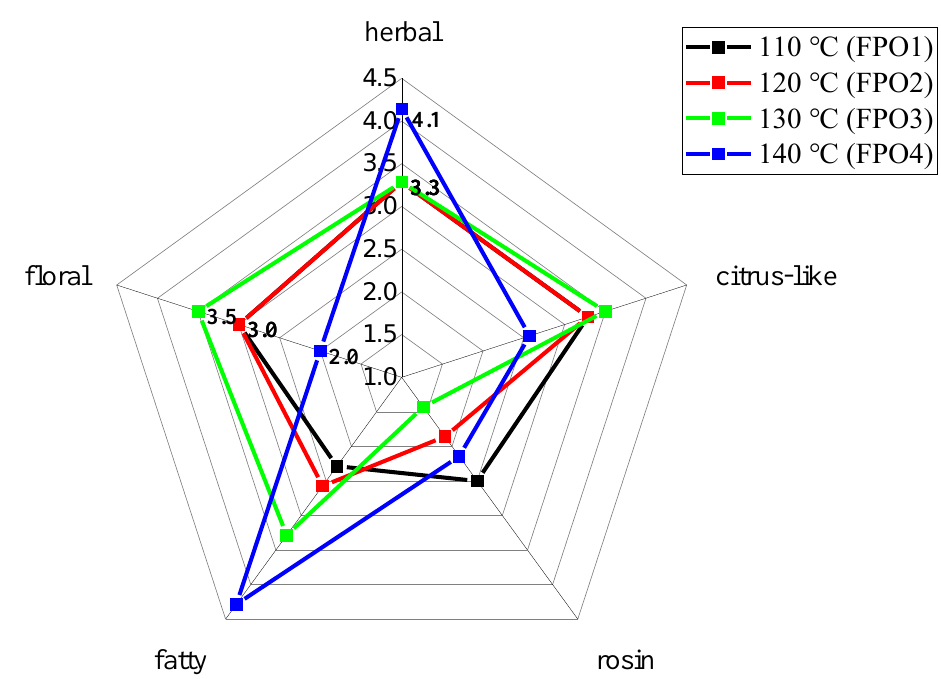
Figure 1. Aroma profiles of FPOs with different frying